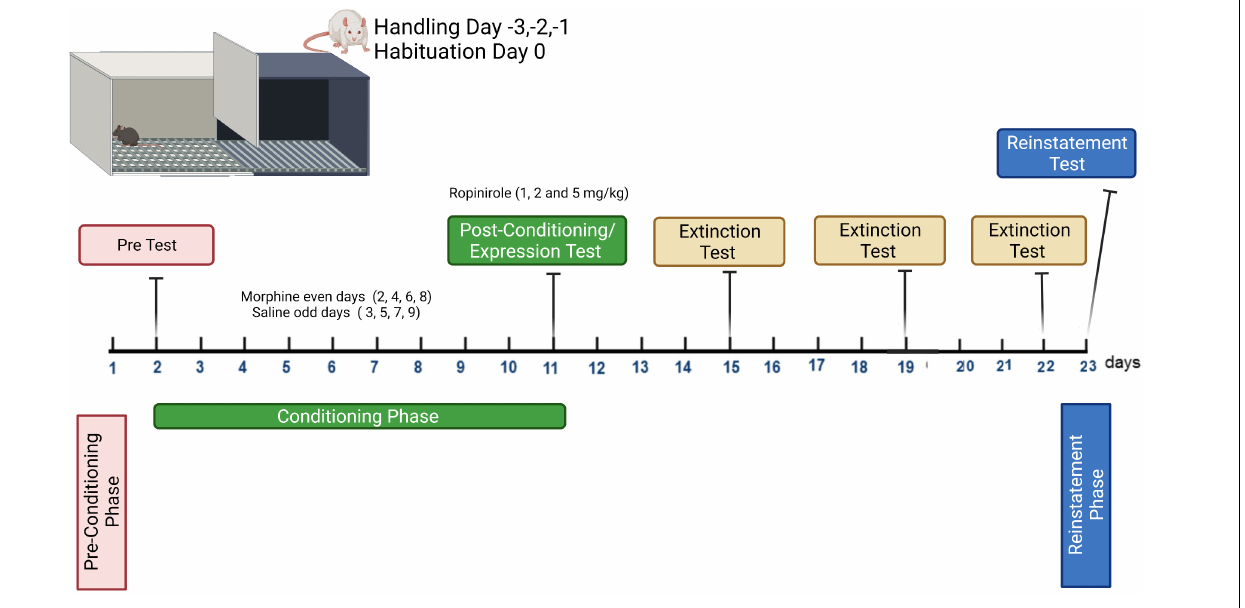
Frontiers in Behavioral Neuroscience |